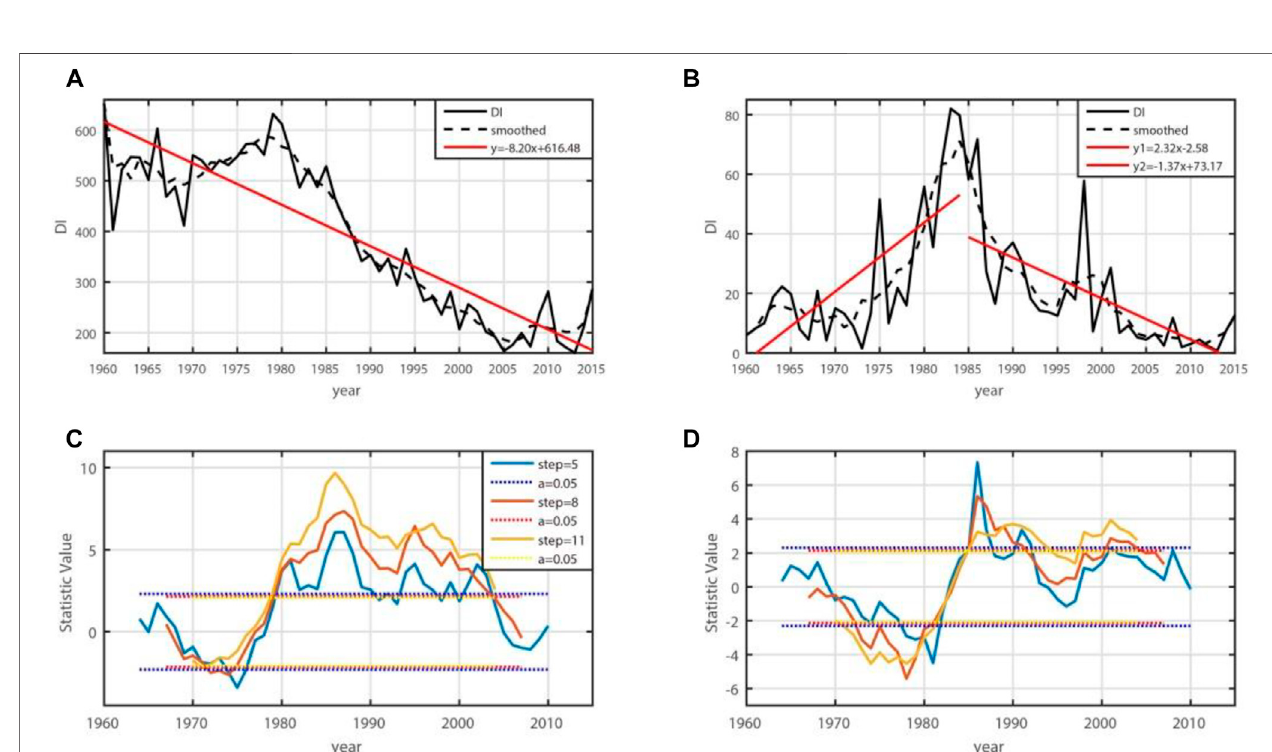
FIGURE 6 | Variations of DI and sliding t -test: Southern Xinjiang (A,C) , Northern Xinjiang (B,D) .